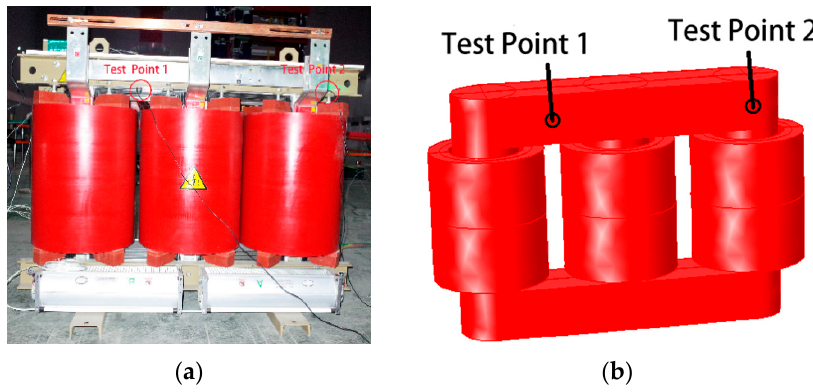
Figure 11. ( a ) Experiment locations of measurement points; ( b ) Simulation locations of measurement points.